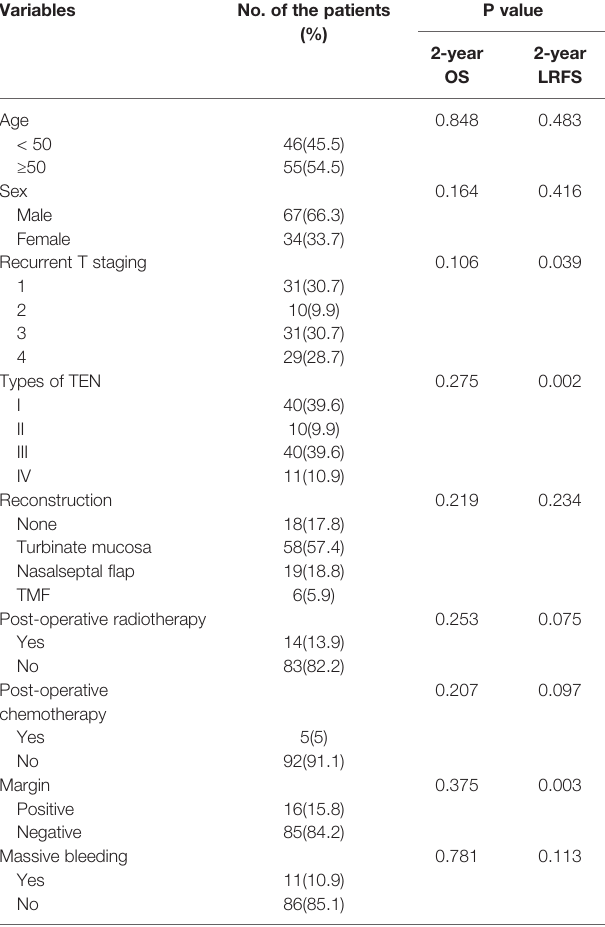
TABLE 1 | Characteristics of patients and univariate analysis of prognostic factors for overall survival (OS) and local recurrence-free survival rate (LRFS).